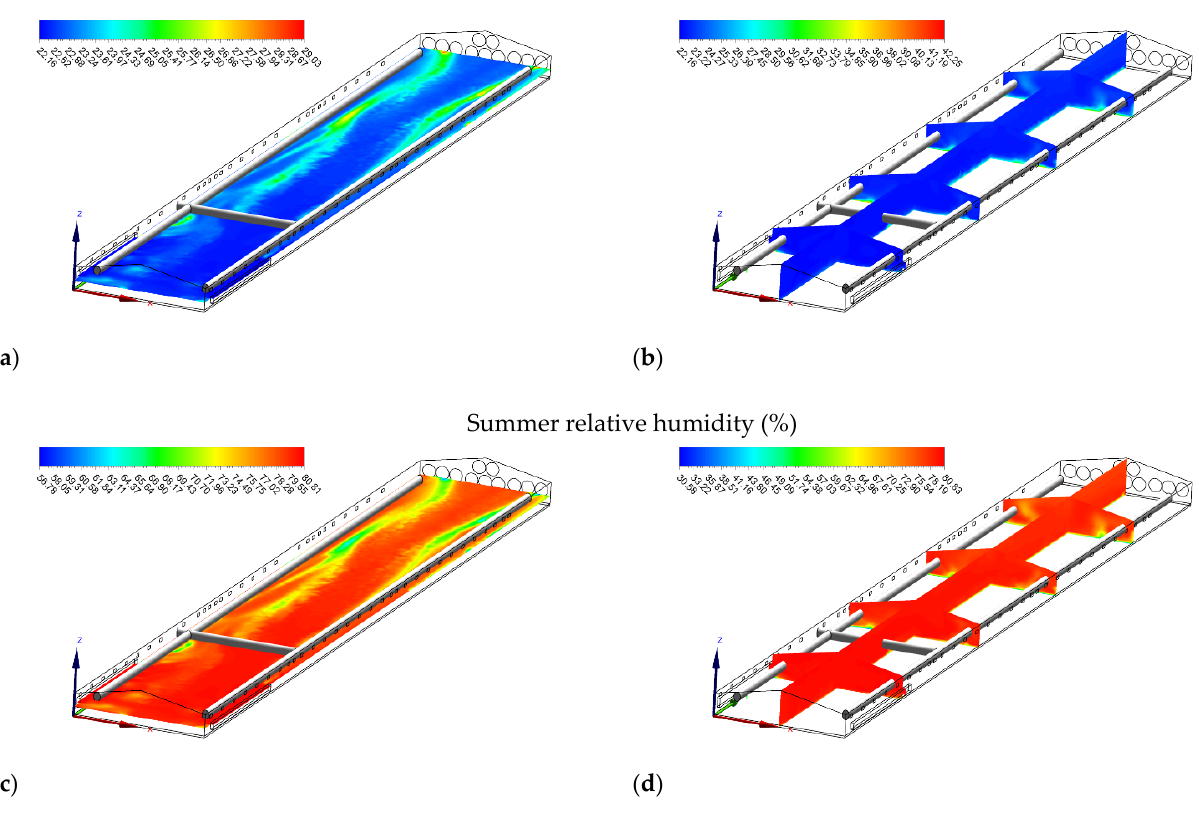
Figure 8. Temperature (°C) ( a , b ) and relative humidity (%) ( c , d ) contours of slice: z = 1 m, and y 1 = 15 m, y 2 = 35 m, y 3 = 55 m, y 4 = 75 m, and x = 7 m in summer when operating evaporative cooling pads.